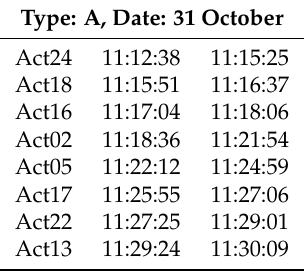
Table 2. Activities of the user.